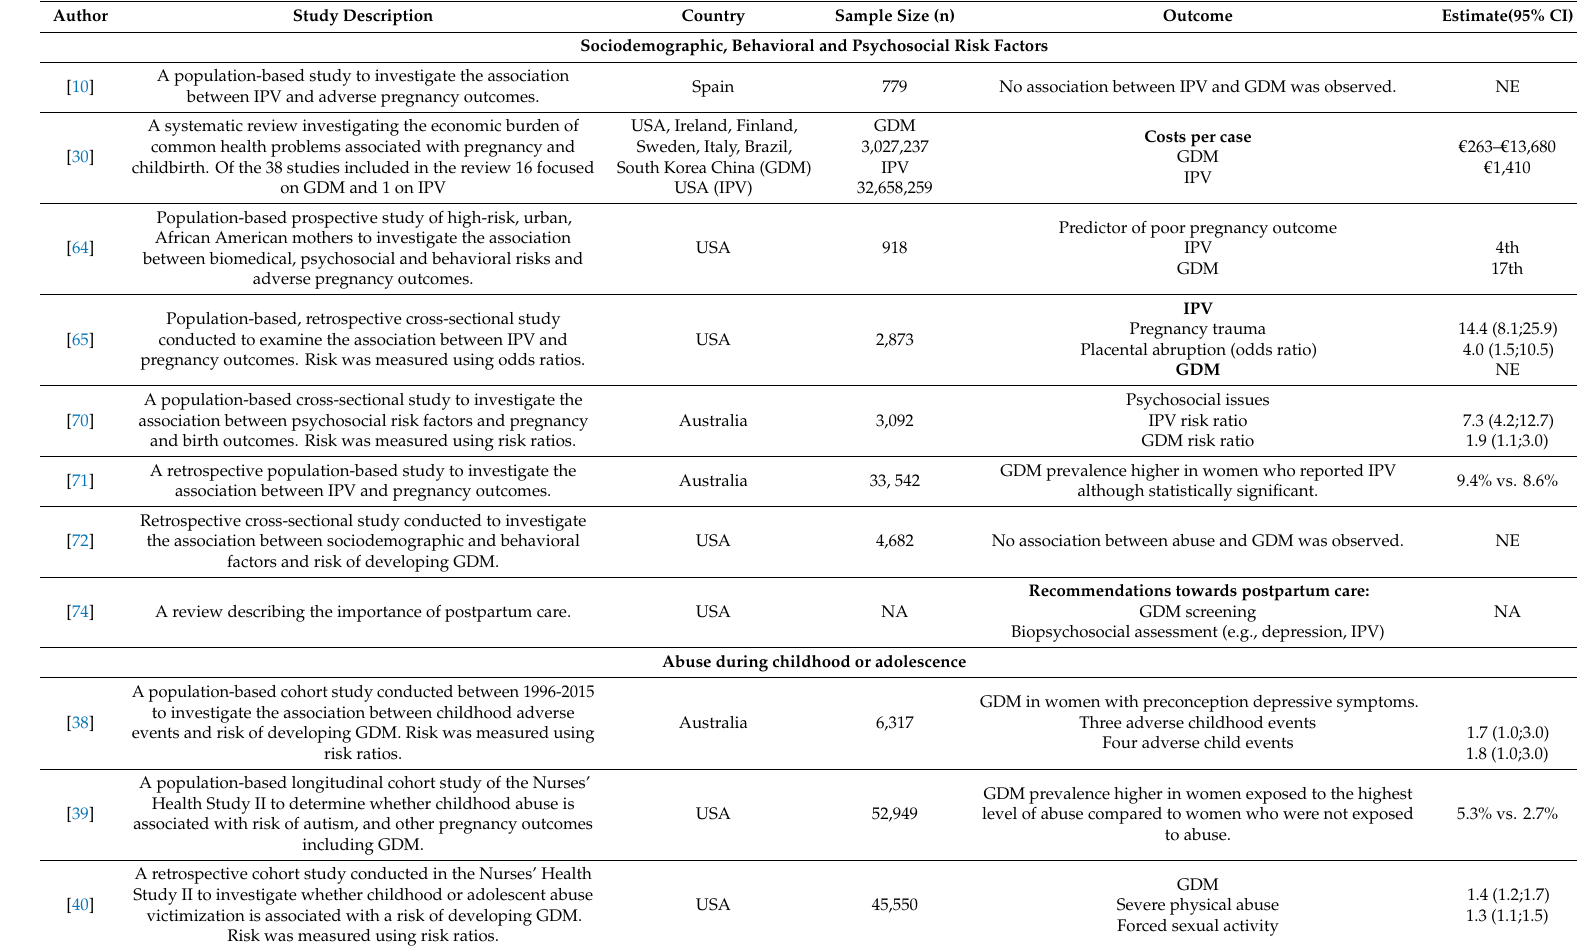
Table 2. Studies that have reported on GDM and IPV /